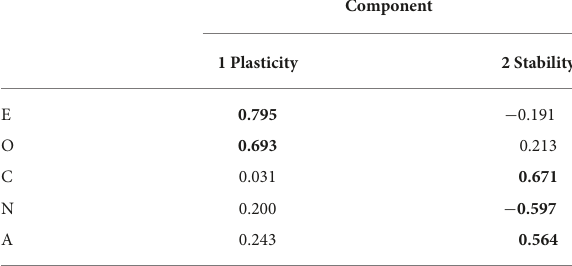
TABLE 4 Solution of the exploratory principal components analysis of the five oblique Big Five